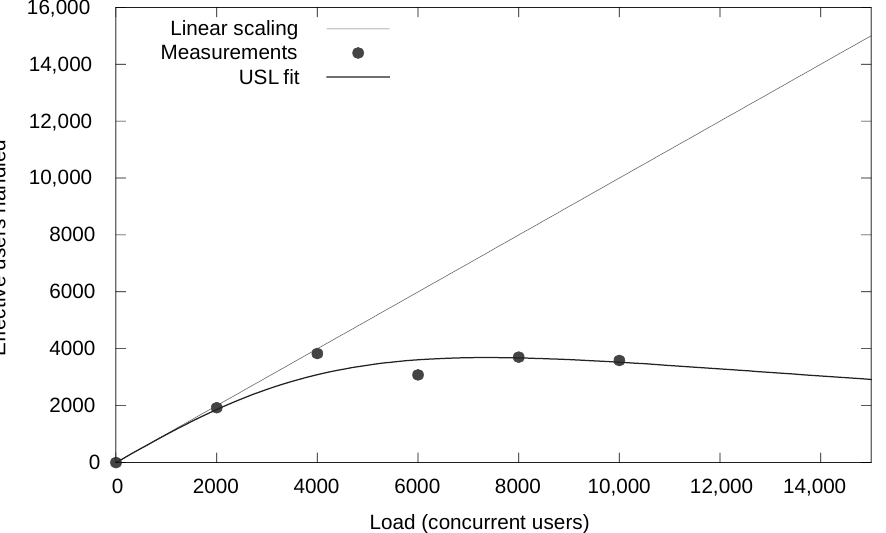
Figure 13. Linear scalability for location updates up to 4000 concurrent users (threads at 10